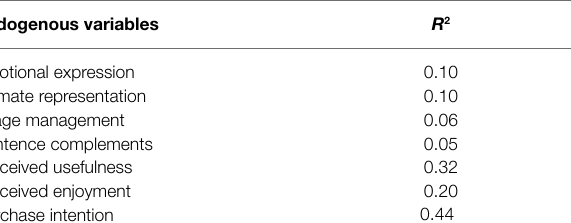
TABLE 8 | Squared multiple correlations between endogenous variables. Endogenous variables R 2 Emotional expression